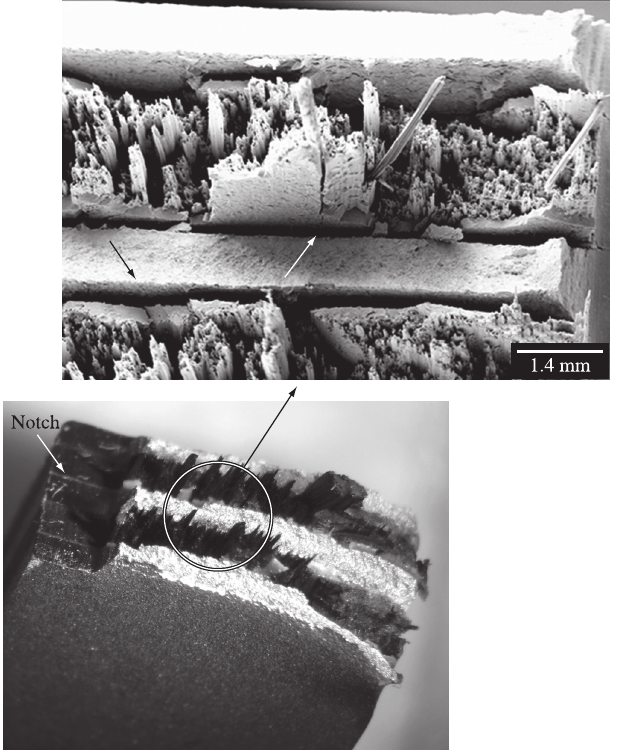
Figure 5. LT oriented FML-TiGr specimen fractured in translaminar mode I at ambient temperature and a loading rate of 5.5 m/s. The insert shows a topographic view by scanning electronic microscopy (SEM). Delaminations are arrowed.